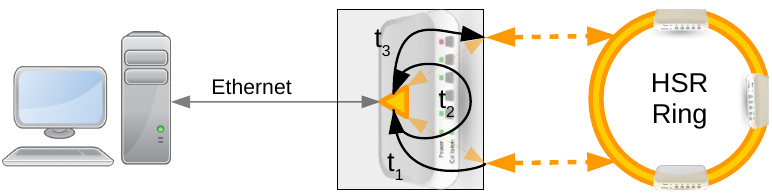
Figure 14. Delays in HSR node. Source node includes t 3 , and destination t 1 + t 2